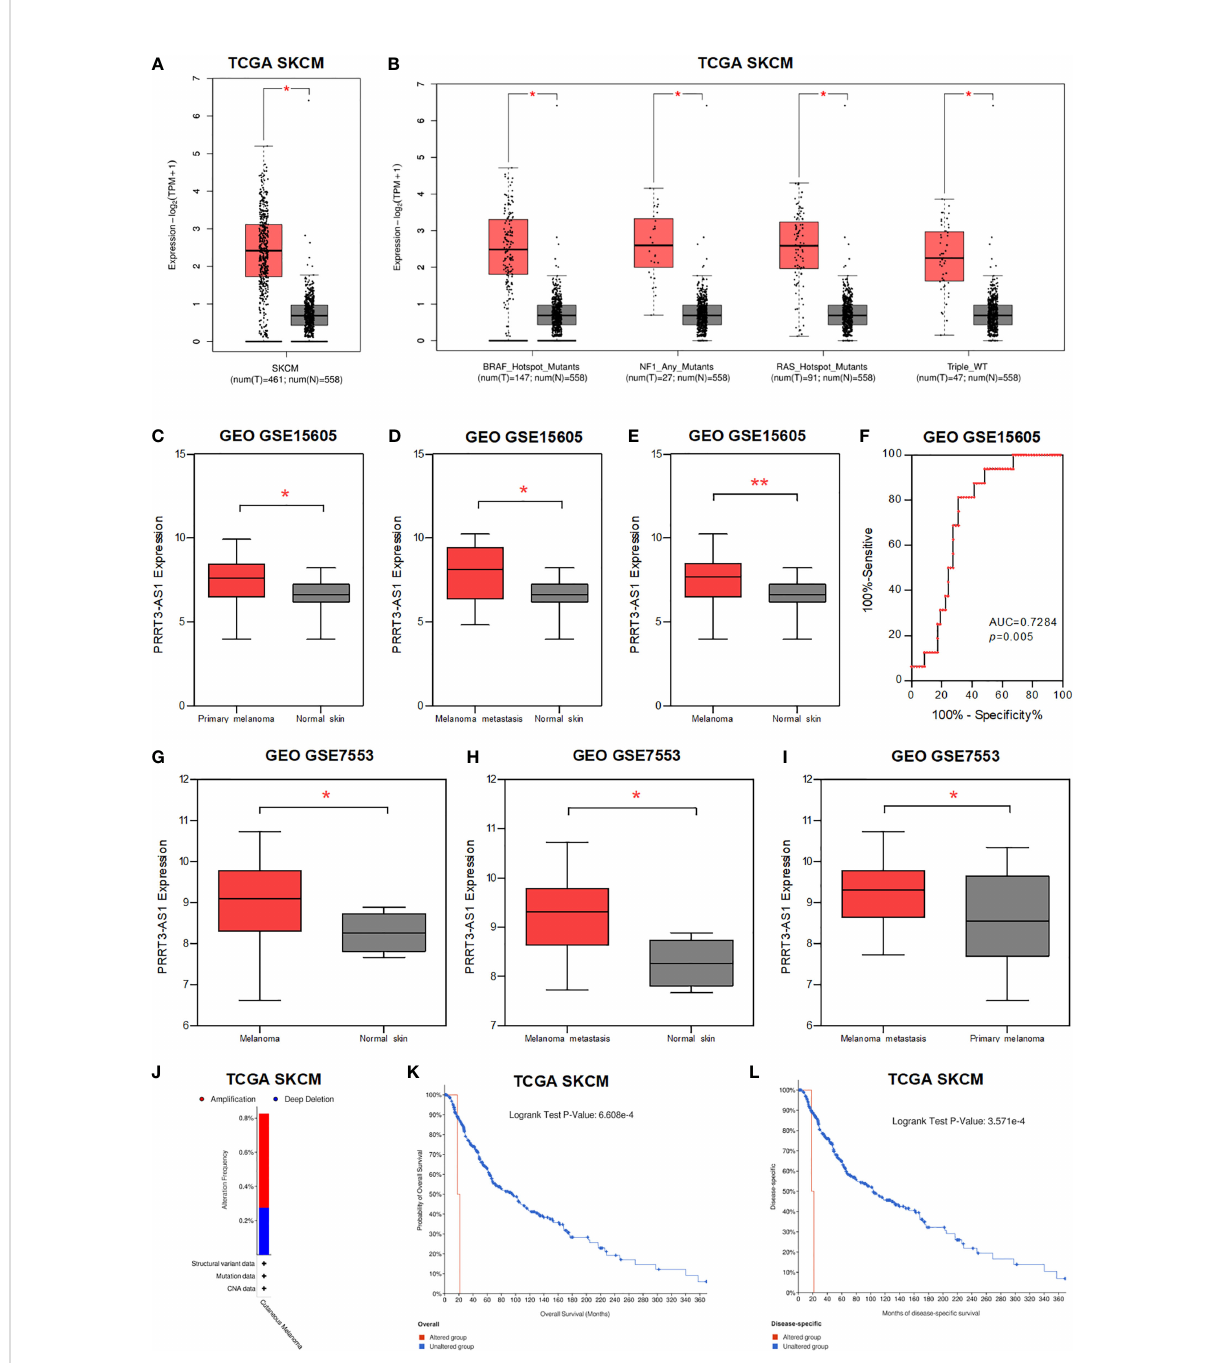
FIGURE 3 The expression and CNV of PRRT3-AS1 in SKCM. (A) The expression of PRRT3-AS1 in normal tissues and melanoma tissues in TCGA-SKCM. (B) The expression of PRRT3-AS1 in normal tissues and melanoma tissues with BRAF, NF1, RAS mutants, and Triple WT in TCGA-SKCM. The expression of PRRT3-AS1 in GSE15605, comparing normal skin tissues with primary melanoma (C) , metastatic melanoma (D) , and primary+metastatic melanoma (E) skin tissues. (F) ROC curves measuring the sensitive and speci fi c values of PRRT3-AS1 in GSE15605. The expression of PRRT3-AS1 in GSE7553, comparing normal skin tissues with ordinary melanoma (G) and metastatic melanoma (H) skin tissues. (I) The expression of PRRT3-AS1 in metastatic melanoma and primary melanoma in GSE7553. (J) PRRT3-AS1 ampli fi cation condition in TCGA-SKCM. Survival curves of PRRT3-AS1 altered grouping in TCGA skin cutaneous melanoma patients with overall survival (K) and months of disease-speci fi c survival (L) in TCGA-SKCM. * P < 0.05, ** P <